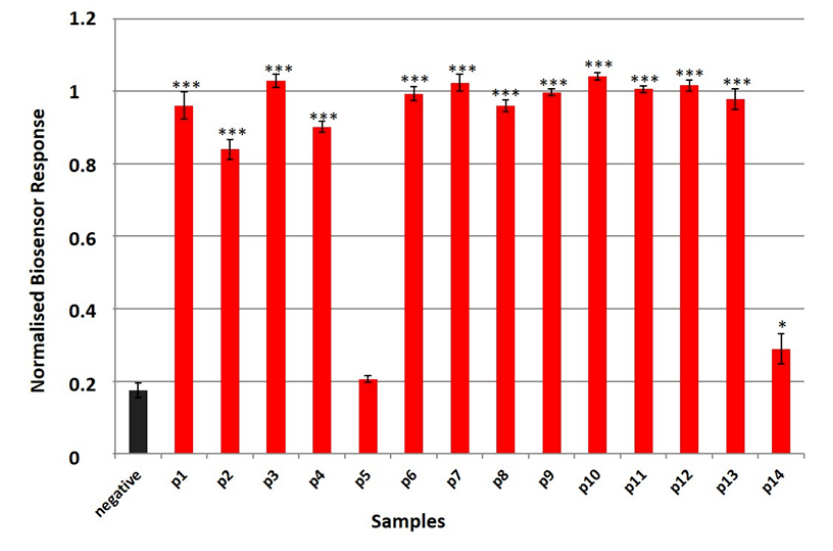
Figure 6. Normalized 3D cell biosensor’s responses against clinical samples from patients ( n = 14) and healthy donors (mean of 10 samples—black column). Results are presented after three minutes of sample–cell interaction. Results are expressed as normalized biosensor responses ([control–sample response]/control). Significant differences (Student’s T -test) between normalized biosensor responses * < 0.05, ** < 0.01, *** <